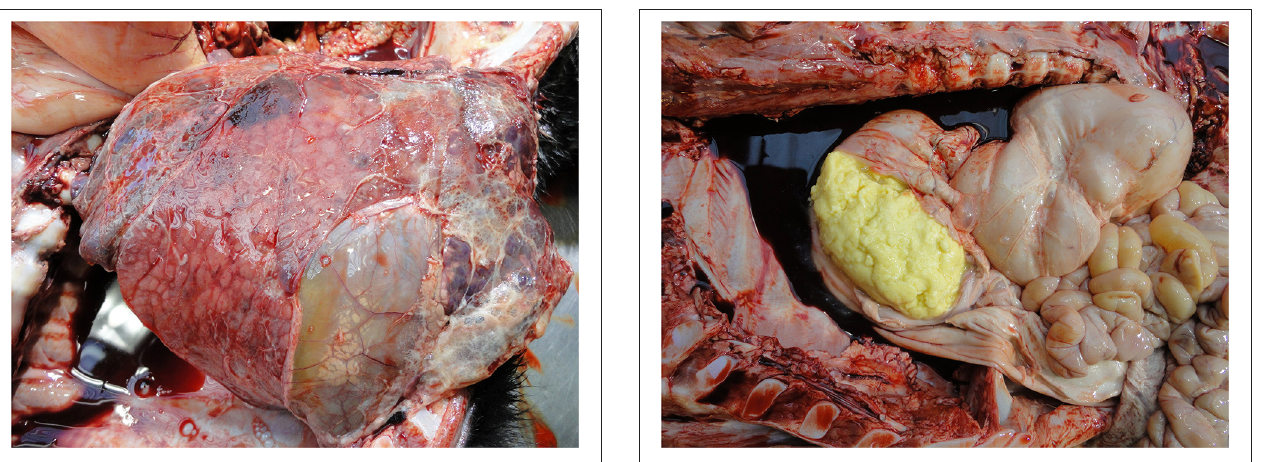
FIGURE 10 | Pneumonia and pleurisy in a calf with respiratory infection. FIGURE 11 | Well-formed curd in the abomasum of a young